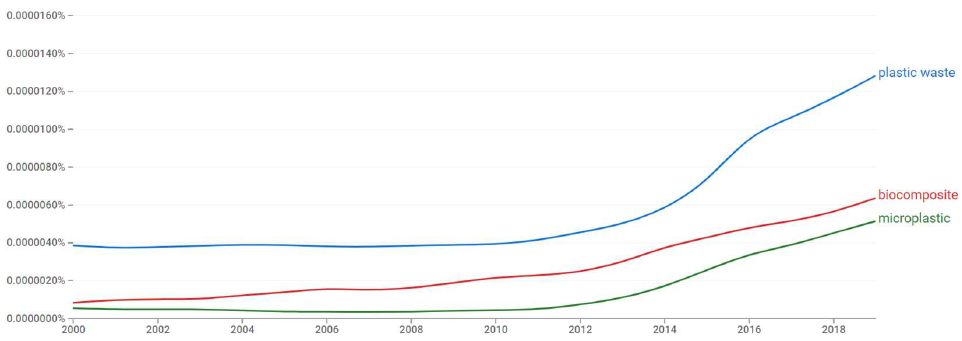
Figure 4. The frequency of using keywords “biocomposite”, “plastic waste”, and “microplastic”, which was created by the authors with Ngram Viewer.